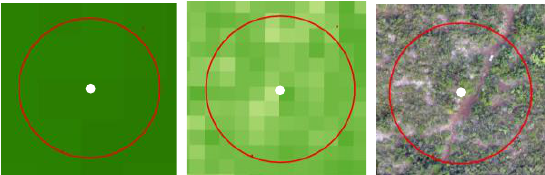
Figure 6: Pie Crust site comparing NDVI for the Landsat imagery collected on December 4, 2018 at 30 meter resolution to the left, Sentinel 2 imagery collected on February 1, 2019 at 10 meter resolution, and the drone imagery collected on January 8, 2019 with a submeter resolution. NDVI images showed more contrast among individual pixels than either true-color or NIR false-color composites, especially for Sentinel 2 data. The diameter of the circles is 100 meters.